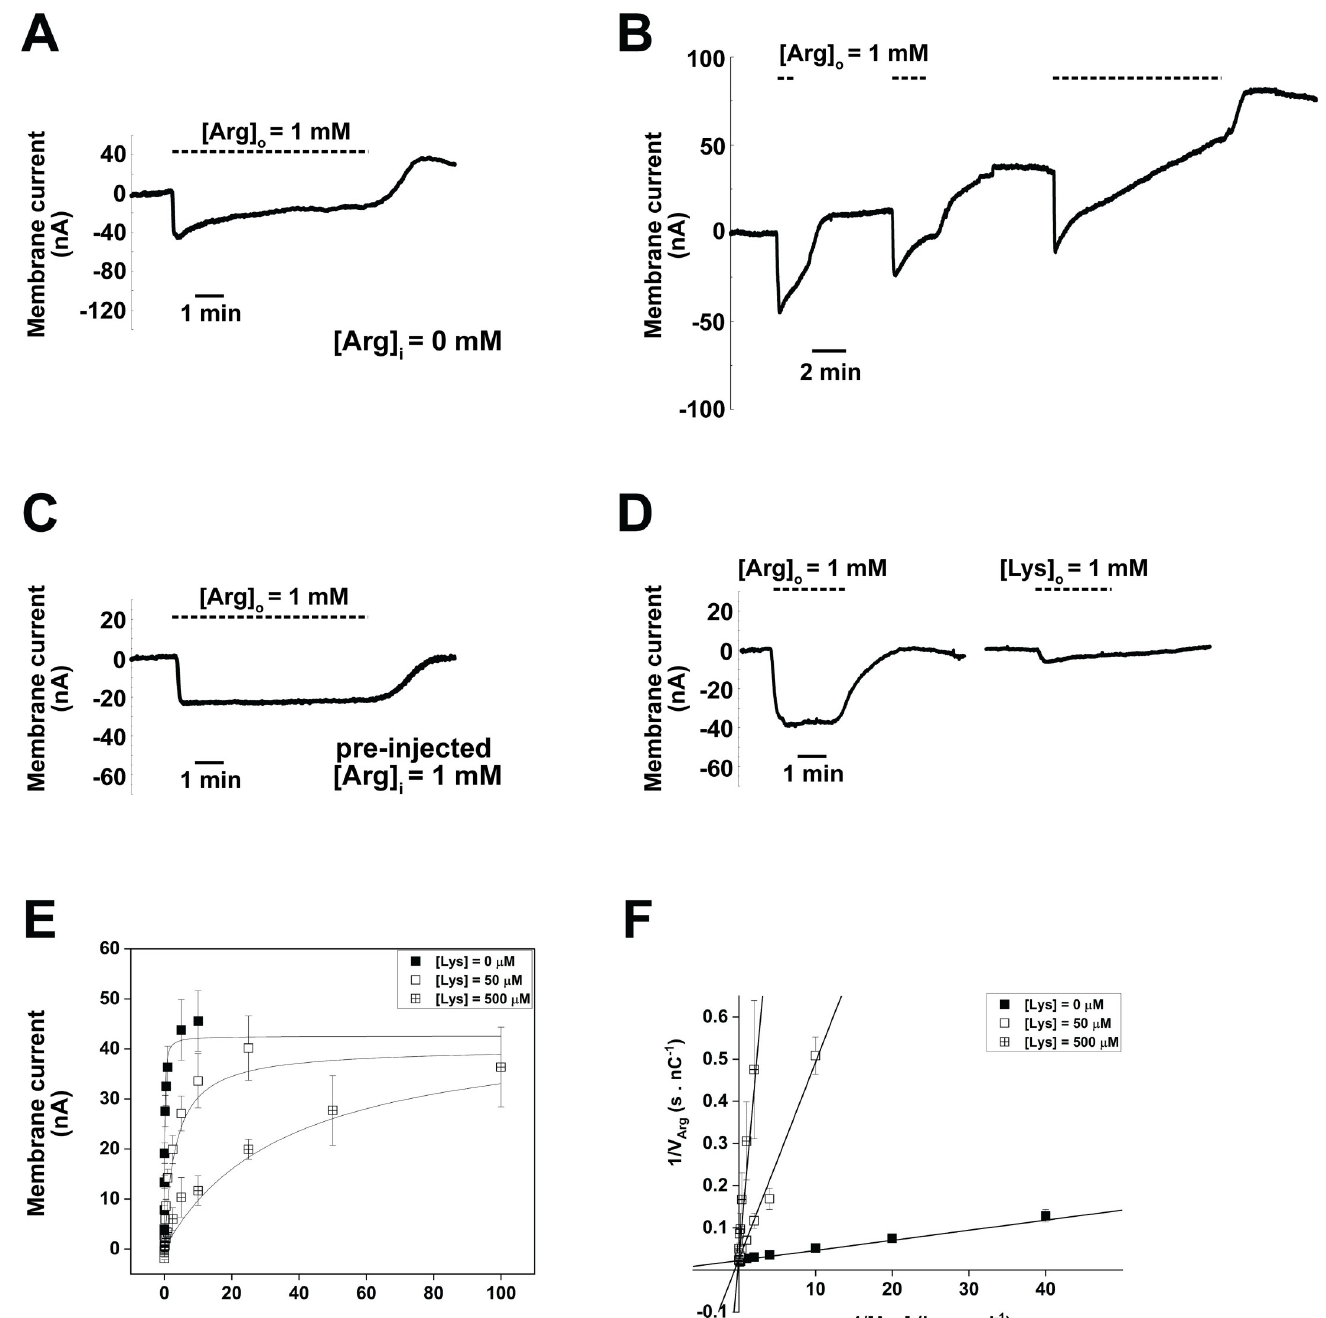
Fig 3. Arg and Lys compete for the same binding site in Tg ApiAT6-1. Electrophysiology measurements in Tg ApiAT6-1 expressing oocytes. All currents were recorded in two-voltage clamp configuration to record membrane current. All oocytes were voltage clamped at − 50 mV and the application of substrate (Arg or Lys) are indicated by the dashed horizontal lines above the tracings. Representative current tracings were normalised to 0 nA to remove background (non-substrate induced) current. A . Representative current tracing of Tg ApiAT6-1 expressing oocytes upon the addition and subsequent washout of 1 mM extracellular Arg ([Arg] o ) with no pre-injection of substrate. The perfusion buffer used was ND96 (pH 7.3). B . Representative current tracing of a Tg ApiAT6-1 expressing oocyte repeatedly pulsed with 1 mM Arg for 1 min, 2 min, and 10 min with 5 min gaps in between pulses. The perfusion buffer used was ND96 (pH 7.3). C . Representative current tracing of a Tg ApiAT6-1 expressing oocyte pre-injected with 1 mM Arg ([Arg] i = 1 mM) upon the addition and subsequent washout of 1 mM extracellular Arg ([Arg] o ). The perfusion buffer used was ND96 (pH 7.3). D . Representative current tracings of Tg ApiAT6-1 expressing oocytes upon the addition and subsequent washout of either 1 mM extracellular Arg ([Arg] o ) or Lys ([Lys] o ) with no pre-injection of substrate. The perfusion buffer used was ND96 (pH 7.3). E-F. Inhibition kinetics of increasing [Lys] on Arg-induced inward currents in Tg ApiAT6-1 expressing oocytes. All oocytes were voltage-clamped at − 50 mV and